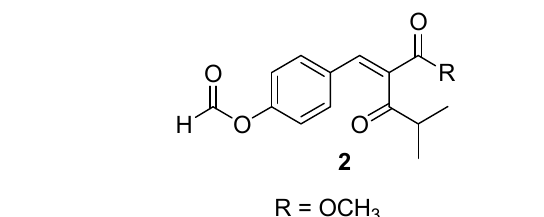
Figure 2. Chemical structure of 4-hydroxycinnamic acid derivative ( 2 ) [21].